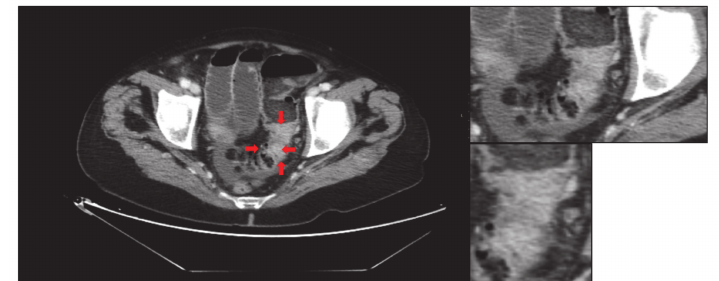
Figure 1. “Large-original” is the first image to obtain. This image belongs to a KRAS + patient included in the study. The tumour under study is highlighted with red arrows and can also be seen in greater detail in the adjacent images.